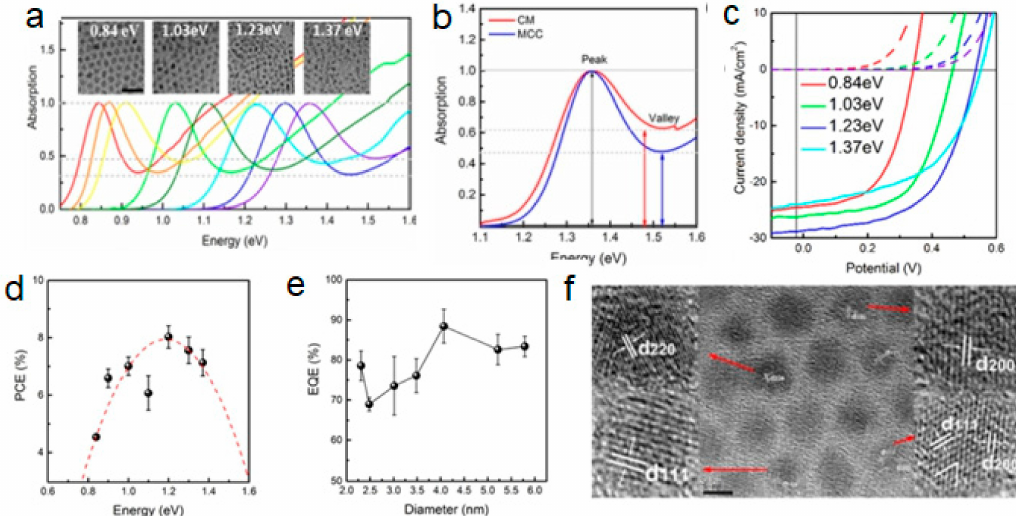
Figure 5. PbS QDs ( a ) absorption spectra. ( b ) Comparison of the first exciton peak. ( c ) Representative J − V curves of QDSSC with PbS QDs. ( d ) PCE values (black legend) as a function of QDs optical ε gap . ( e ) Peak EQE values measured at a 400 nm wavelength. ( f ) HRTEM images (reproduced from ref. [61] with permission from the American Chemical